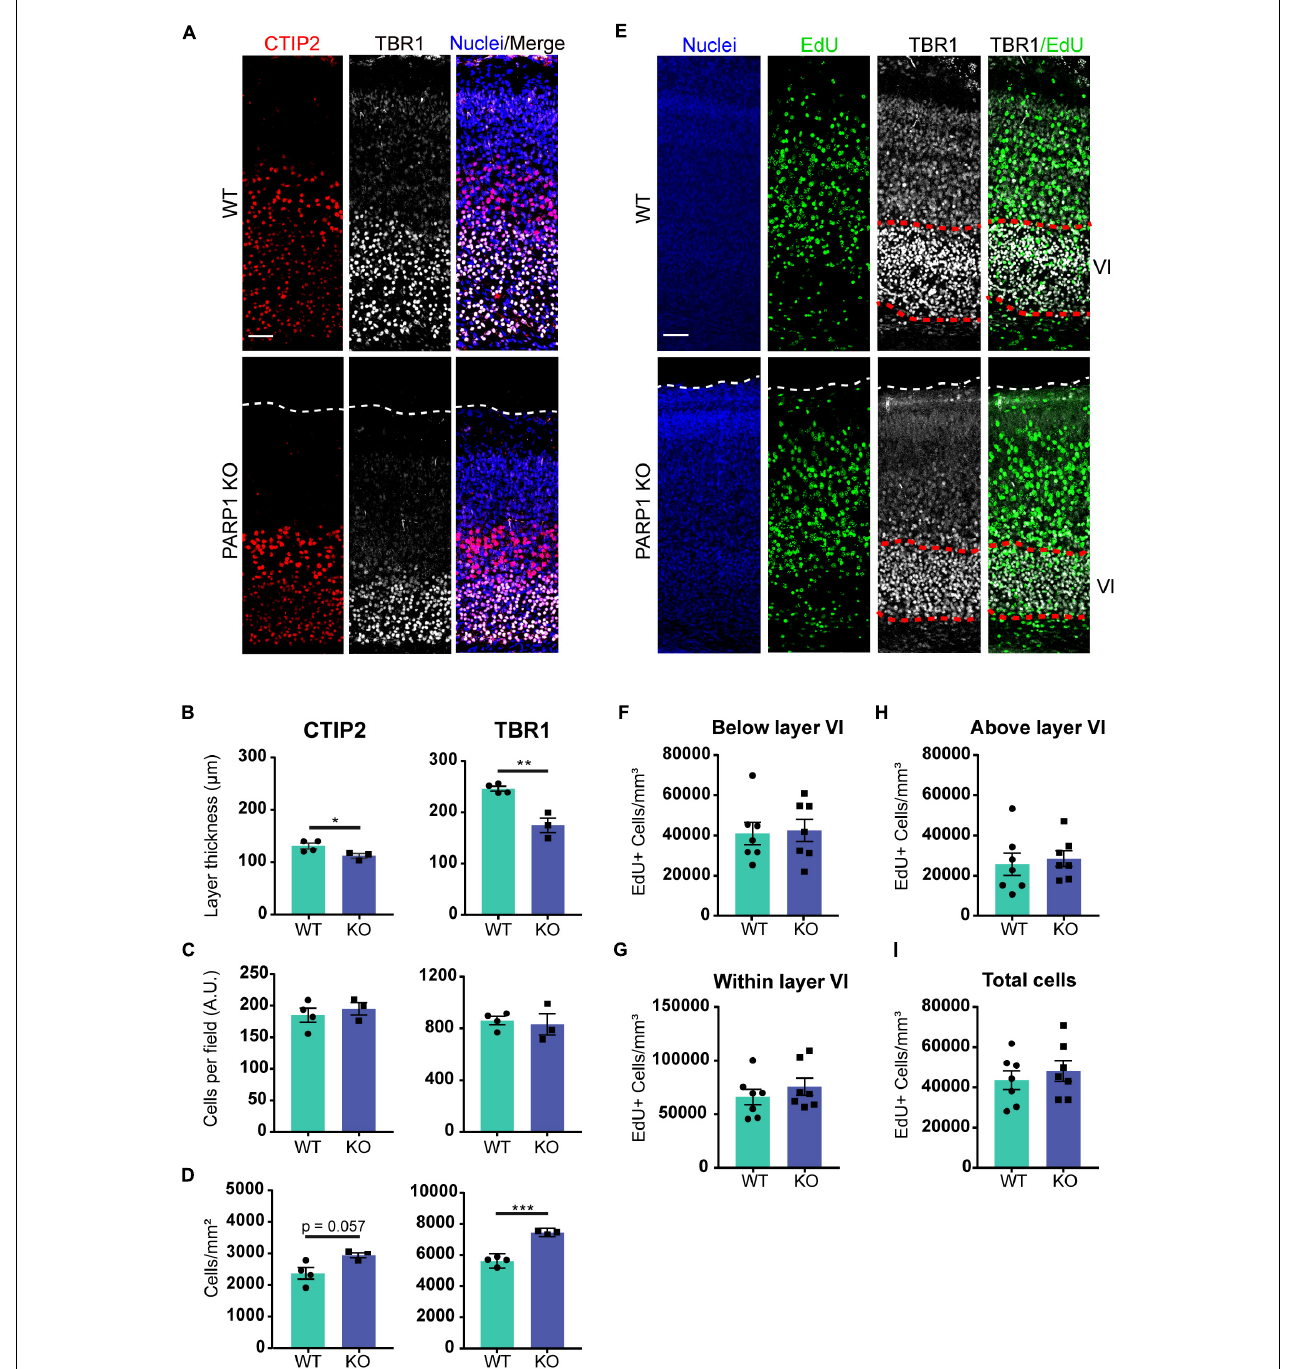
FIGURE 2 | Poly (ADP-ribose) polymerase 1 KO mice have defects in cortical development. (A) Representative images from CTIP2+ (red, layer V) and TBR1+ (white, layer VI) cells in the cortex of P0 mice. Nuclei were labeled with DAPI (blue). Scale bar, 50 µ m. (B) The thickness of TBR1 and CTIP2-expressing cell layers is decreased in KO P0 brains. * p = 0.0498, ** p = 0.0026 by Student’s unpaired t -test. (C) The number of TBR1 and CTIP2 positive cells per field in P0 brains does not differ between genotypes. (D) The density of CTIP2+ and TBR1+ cells is increased in KO P0 brains. *** p = 0.0002 by Student’s unpaired t -test. (A–D) n = 4 WT and 3 KO animals from 2 L, average of three sections in the somatosensory cortex region per animal and three images per section. (E) Representative images of coronal cortical sections at P0 of mice in which proliferating cells (green) were labeled by injecting EdU (IP, 50 mg/kg) to the dam at day 13.5 of pregnancy. Nuclei were labeled with DAPI (blue), and images were co-stained with layer VI marker TBR1 (white). Scale bar, 50 µ m. (F) PARP1 loss does not alter the number of EdU-labeled cells below layer VI, (G) within layer VI, or (H) above layer VI. (I) PARP1 loss does not alter the total number of EdU-labeled cells at E13.5 (E–I) n = 7 animals per genotype, average of three sections in the somatosensory cortex region per animal and three images per section.